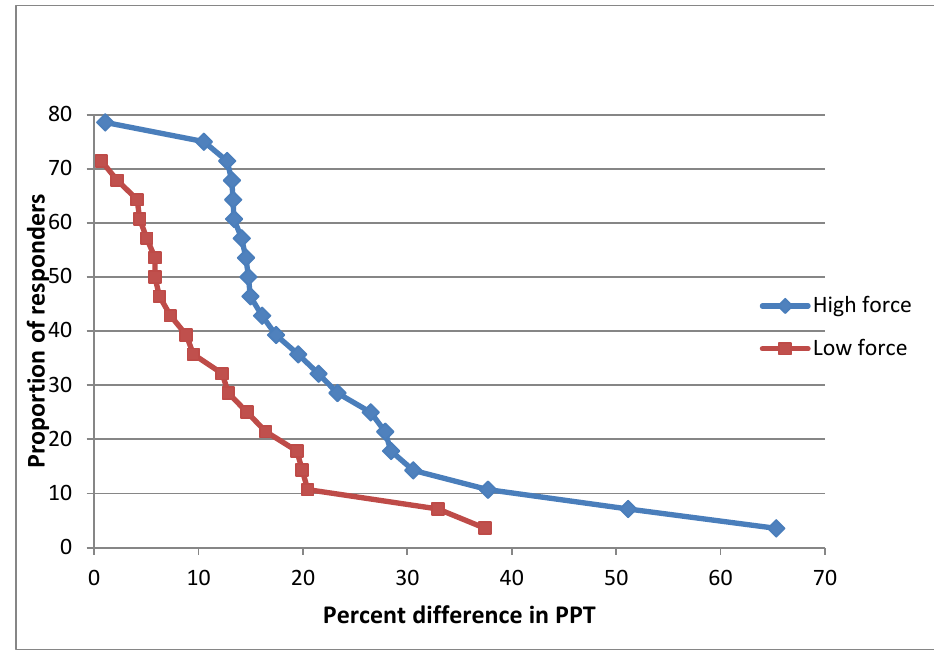
Figure 6. Cumulative proportion of responders analysis graph Fibula after high and low mobilizations.